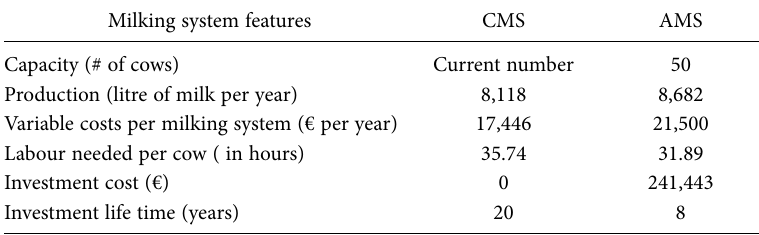
Table 3. Descriptive statistics of the milking system